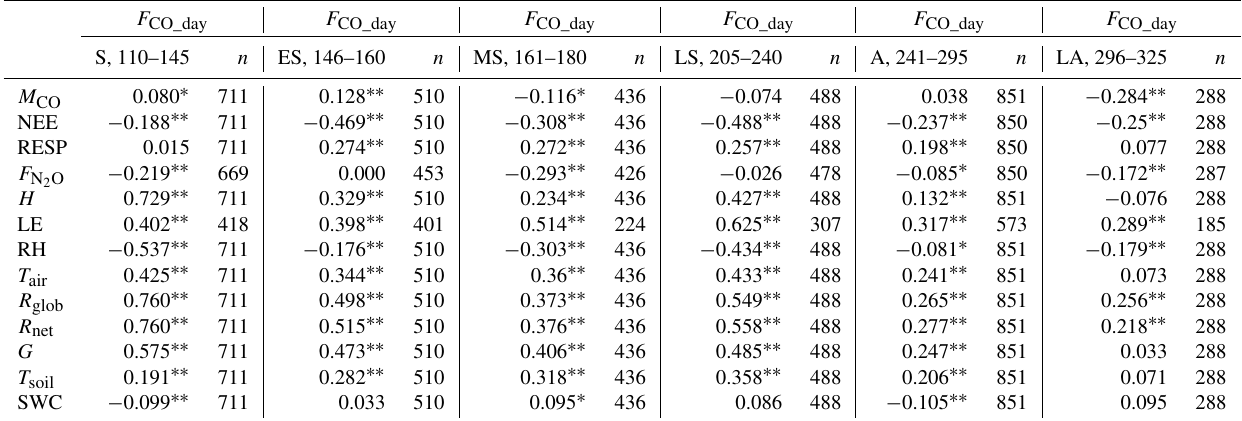
Table 3. Pearson correlation matrix for half-hour daytime CO fluxes ( F CO_day ) during six periods (S is spring, ES is early summer, MS is midsummer, LS is late summer, A is autumn, LA is late autumn) at the reed canary grass crop in Maaninka. M CO is CO mixing ratio, NEE is net ecosystem exchange, RESP is ecosystem respiration, F N is N 2 O flux, H is sensible heat flux, LE is latent heat flux, T air is air 2 O temperature, R glob is global radiation, R net is net radiation, G is soil heat flux, T soil is soil temperature at 2.5cm, SWC is soil water content at